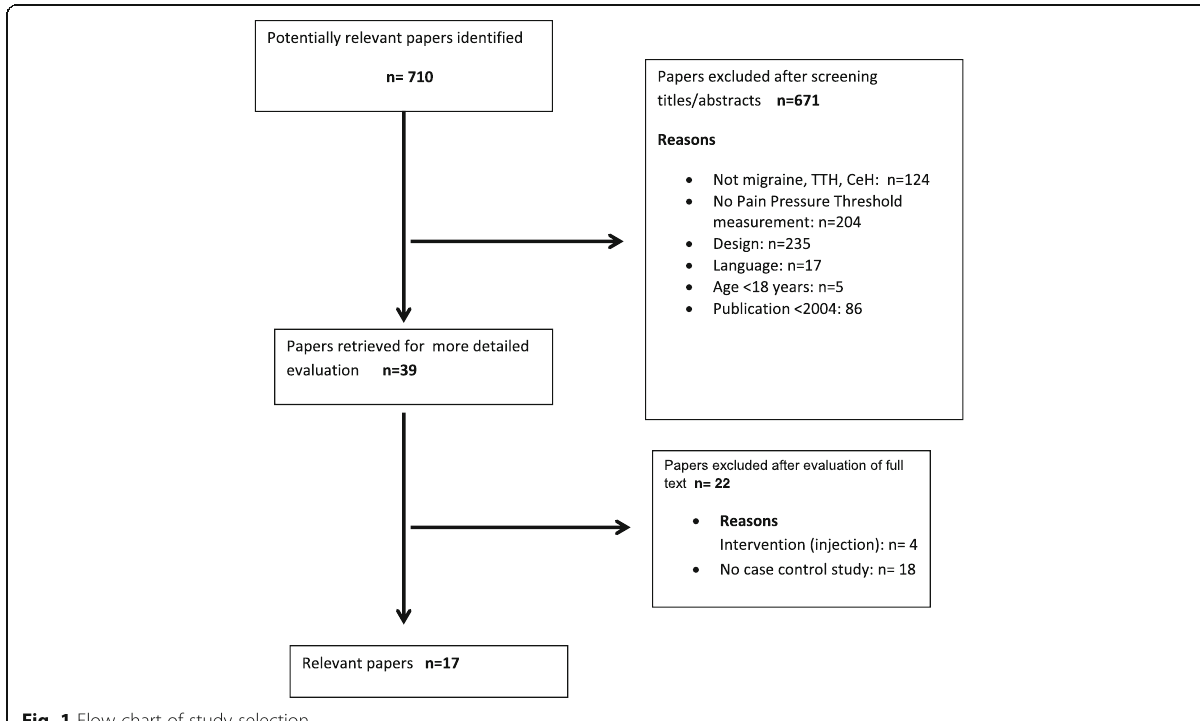
Fig. 1 Flow chart of study